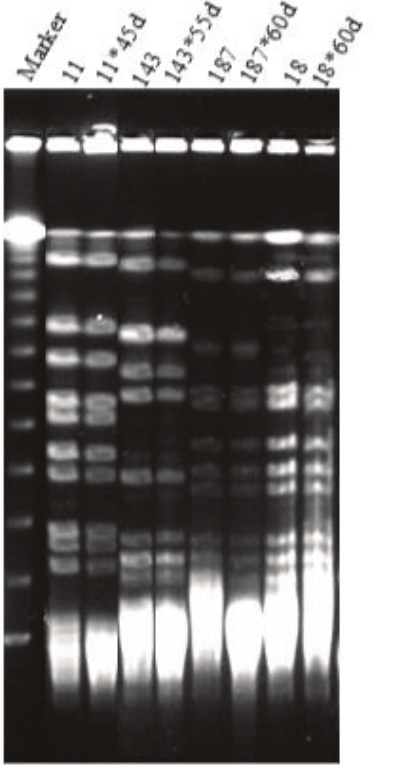
Figure 3: The cell wall thickness (nm) of representative parental strains and their vancomycin-resistant derivated strains. Microscope magnification: ×30,000